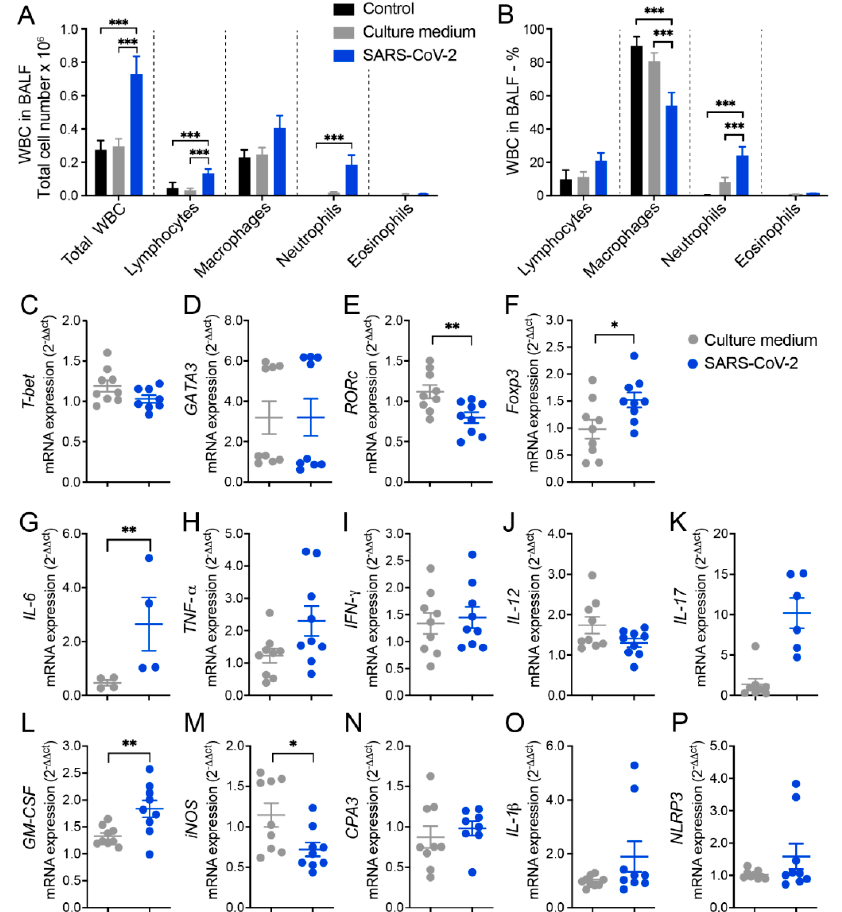
Figure 1. Cell counts in the BALF and lung mRNA transcripts for T cell subsets, cytokines, and other indicators of inflammation in mice intranasally instilled with UV-inactivated SARS-CoV-2. C57BL/6 mice were instilled with the virus (3 doses of 4 × 10 5 PFU/each) on days 1, 3, and 5. On the 7th day, the BALF and the left lower lobe were collected for WBCs differential count and mRNA transcript determinations, respectively. Total number ( A ) and percentage ( B ) of WBCs: T - bet ( C ), GATA3 ( D ), RORc ( E ), Foxp3 ( F ), IL - 6 ( G ), TNF - α ( H ), IFN - γ ( I ), IL - 12 ( J ), IL - 17 ( K ), GM - CSF ( L ), iNOS ( M ), CPA3 ( N ), IL - 1 β ( O ), NLRP3 ( P ). In figure ( A , B ), the results are expressed as mean ±